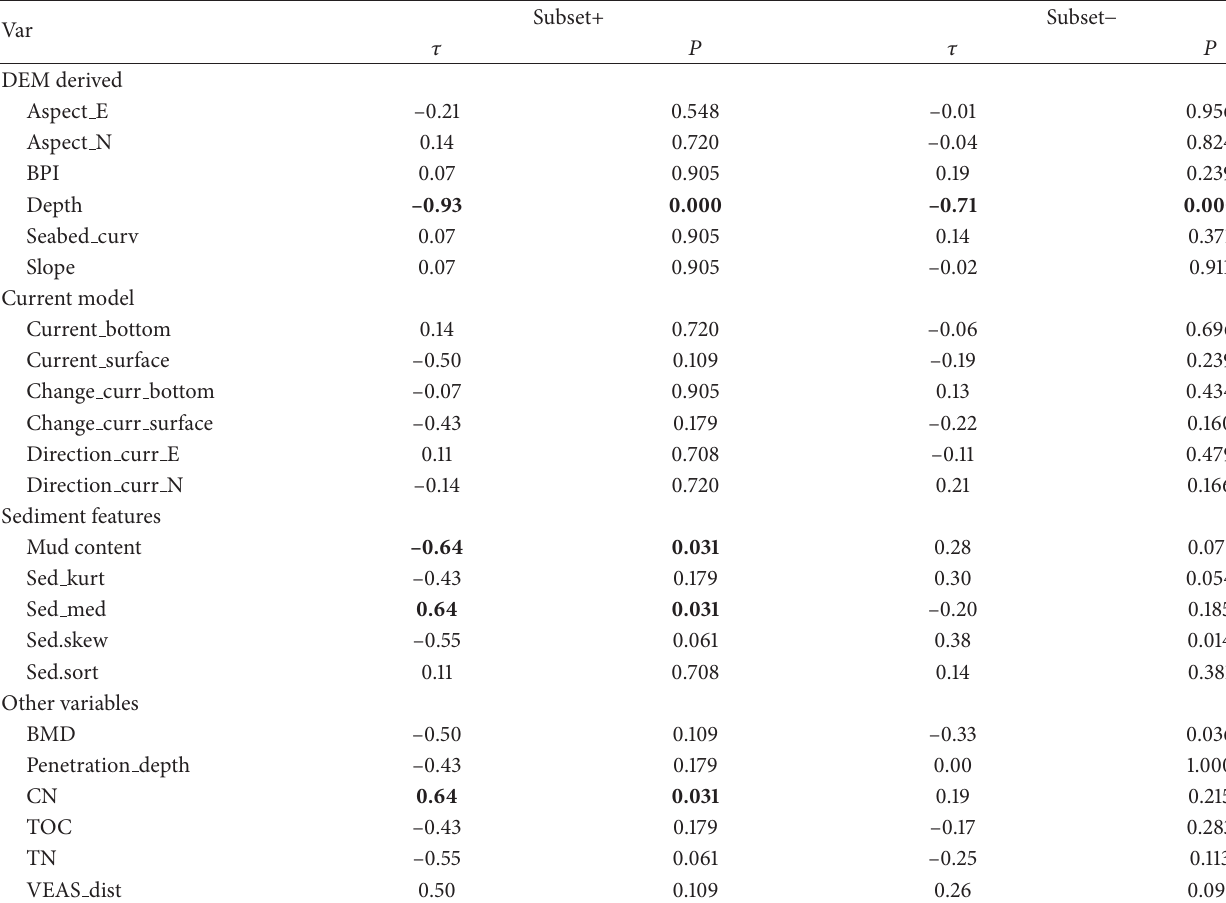
Table 6: Kendall’s rank correlation coefficients 𝜏 between environmental variables and site scores along DCA axis 1, calculated separately for subsets of sites near the positive (Subset+; 𝑛 = 8 ) and negative ends (Subset − ; 𝑛 = 22 ; sites 4 and 6 are included in both subsets) of the axis. Correlation coefficients 𝜏 > 0.6 are shown in bold. See Table 2 for description of environmental variables.